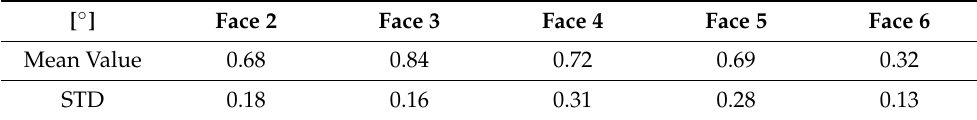
Table 1. Alignment procedure accuracy.